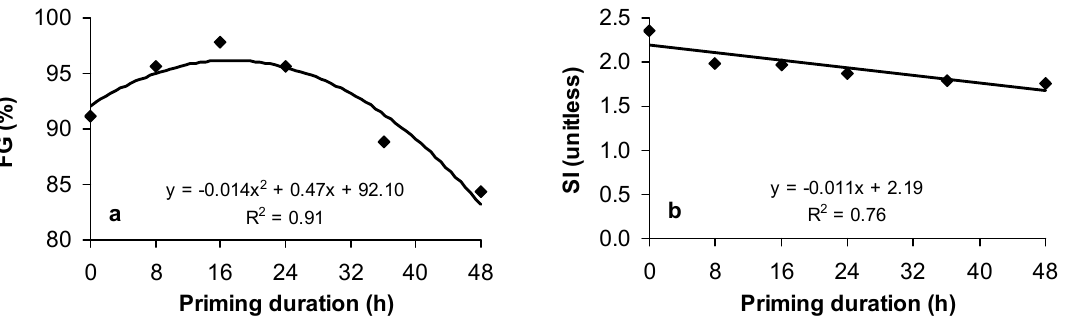
Figure 1. Regression equations ( a ) between priming duration and final germination (FG) and ( b ) between priming duration and synchronization index (SI).